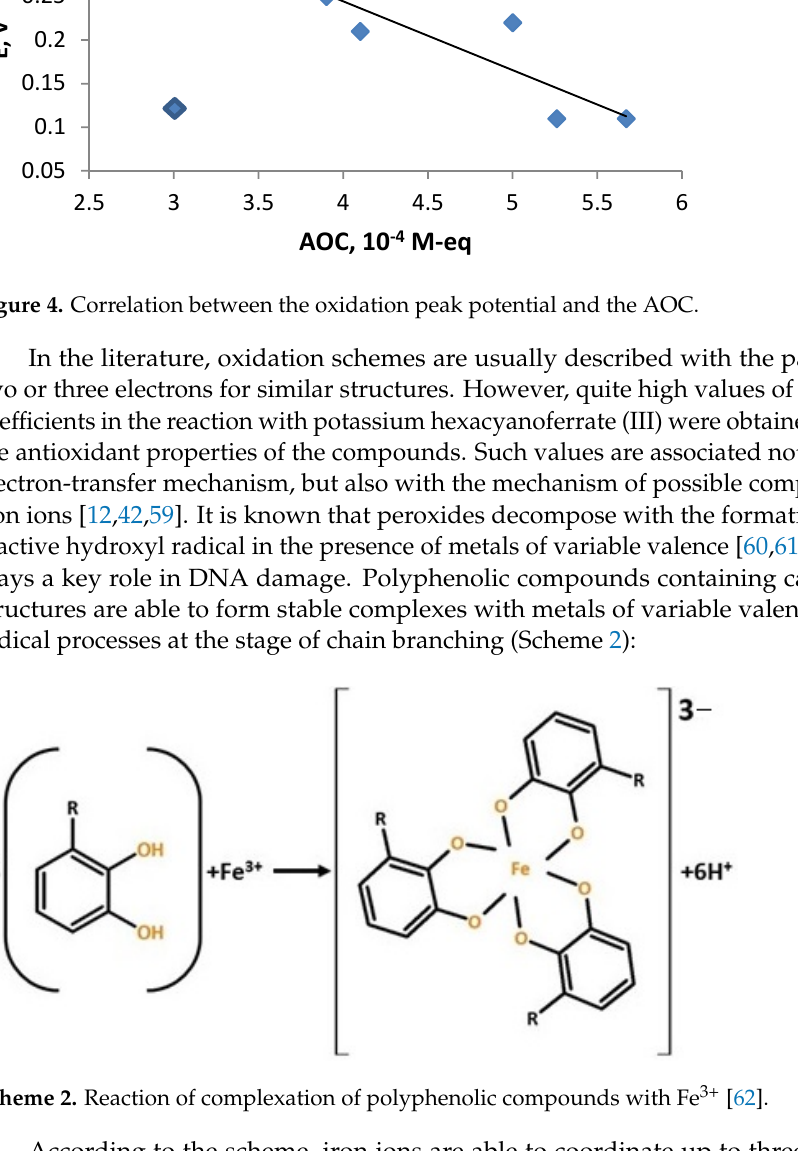
Scheme 2. Reaction of complexation of polyphenolic compounds with Fe 3+ [62].